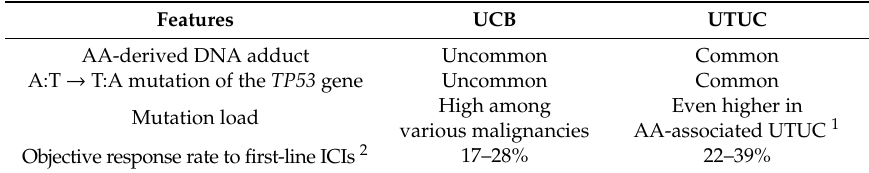
Table 1. Comparisons between UCB and UTUC in terms of genetic mutation and currently-known clinical responses to